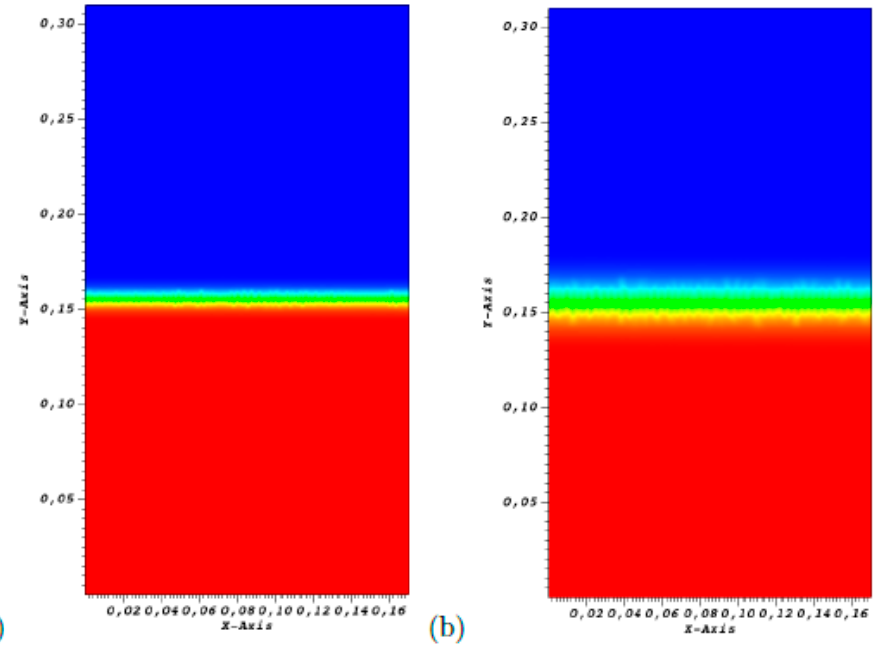
Figure 4. Predicted normalized sucrose concentration for R ρ = 1.4 calculated with the SUPG stabilization method and the stabilization parameter of Christie et al. [32]. ( a ) t = 52 min; ( b ) t = 166 min.